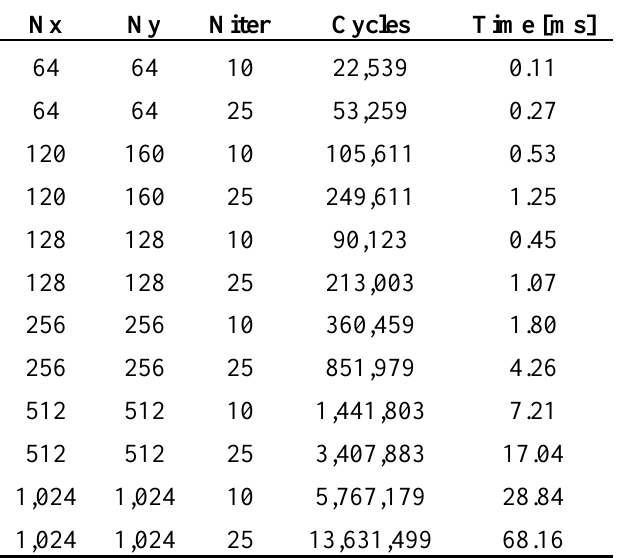
Table 3. Execution time for the belief algorithm in